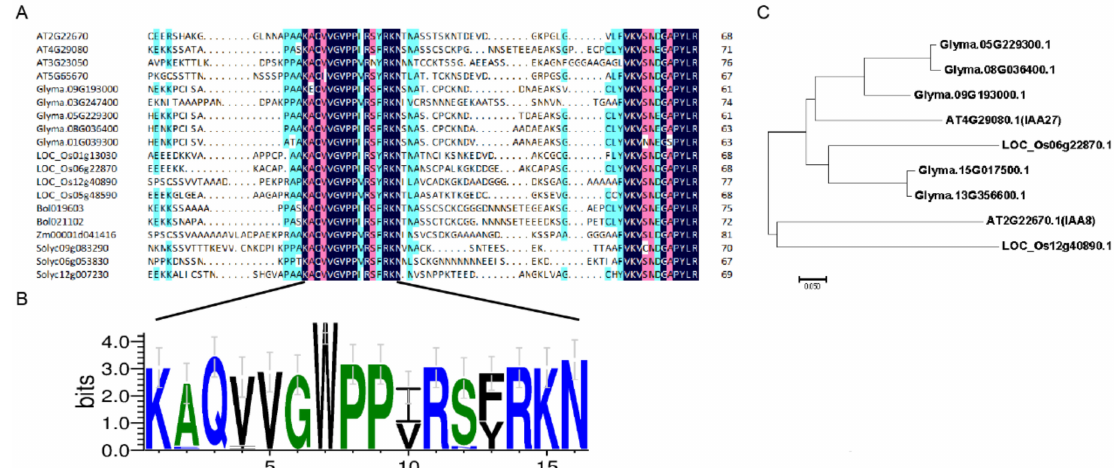
Figure 4. Sequence alignment and phylogenetic analysis of GmIAA27 with homologue genes. ( A ) Alignment of partial amino acid sequence surrounding the 160th amino acid of Aux/IAA pro- teins from several plant species. ( B ) Conserved-sequence analysis of the partial amino acid sequence surrounding the 160th amino acid of Aux/IAA proteins from several plant species. ( C ) Phylogenetic tree of Glyma.09G193000 and its gene homologs in soybean, Arabidopsis , and rice.